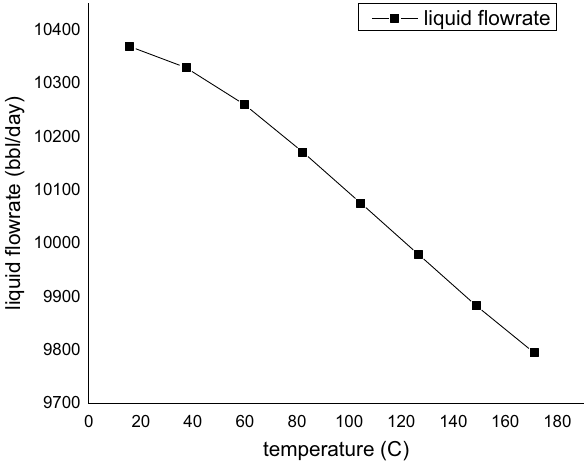
Fig. 6 Effect on oil production concerning